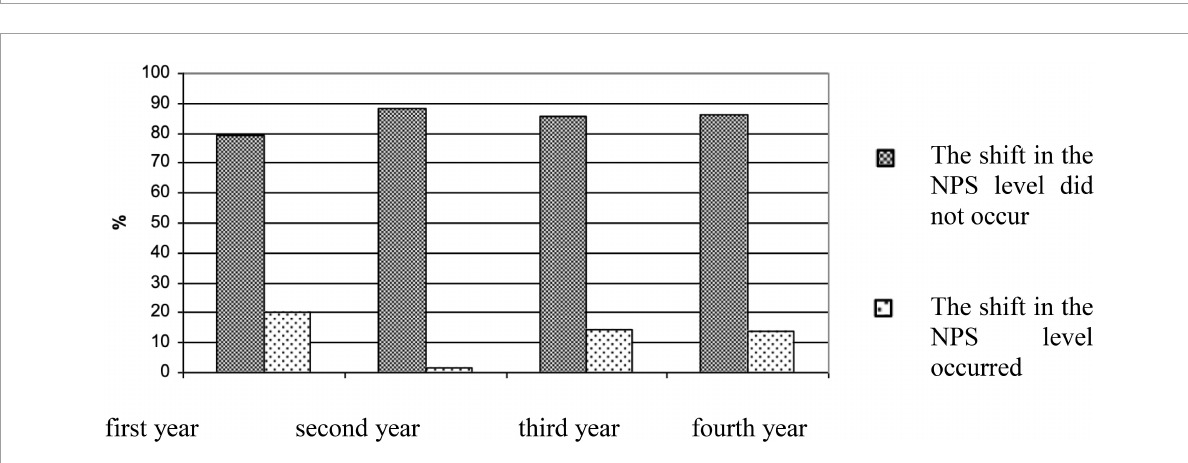
FIGURE2 Frequency of occurrence of a changed and unchanged level of neuropsychic strain in psychology students of the second age subgroup during the academic day (in